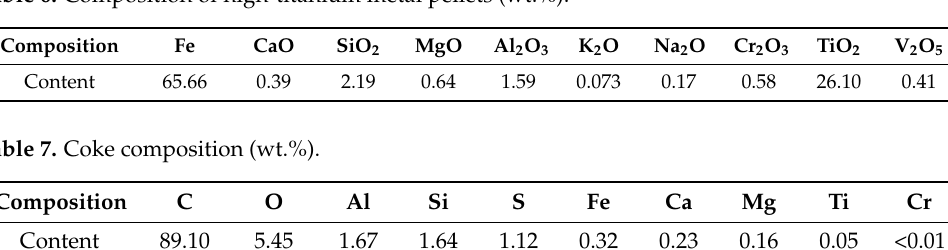
Table 6. Composition of high-titanium metal pellets (wt.%).